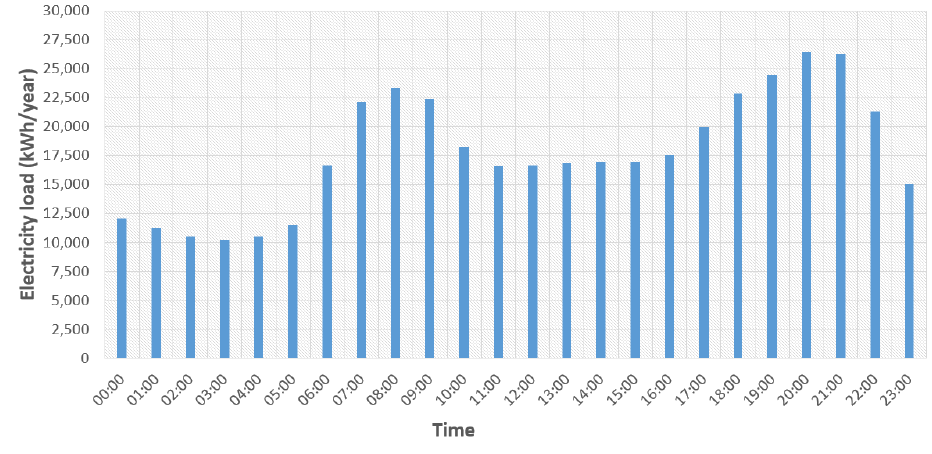
Figure 4. Building load